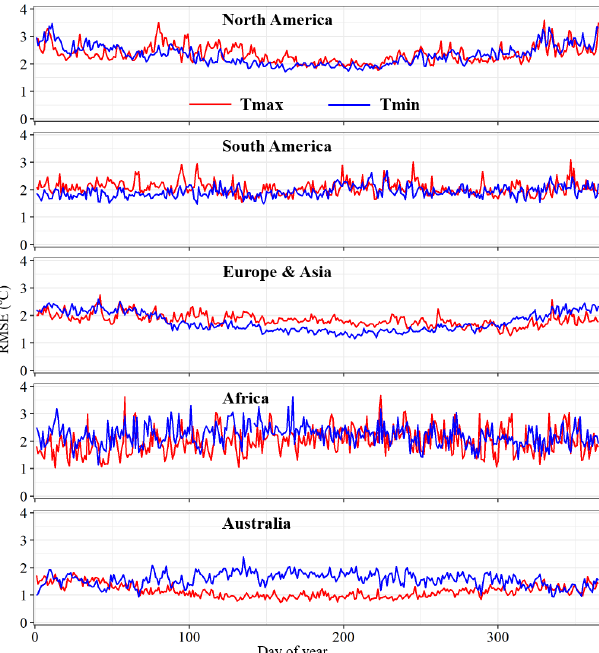
Figure 5. Temporal patterns of accuracies in estimated T a in differ- ent regions in the year